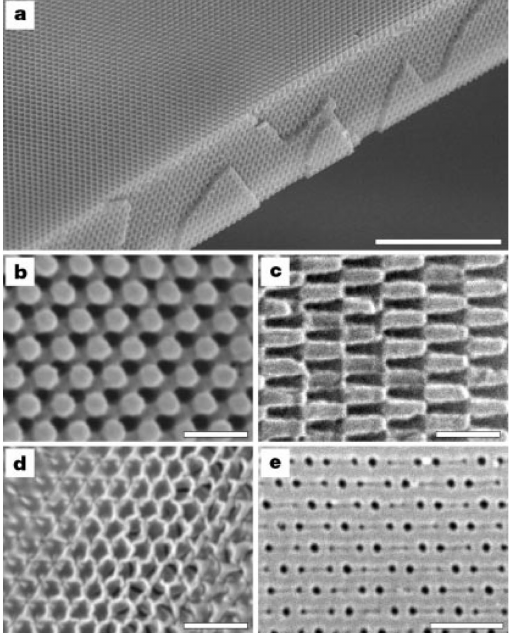
Figure 11. SEM images of SU-8/air 3D photonic crystals generated by holographic lithography. ( a ) Photonic crystal generated in 10 μ m thick SU-8 (scale bar: 10 μ m); ( b ) close-up of a (111) surface (scale bar: 1 μ m); ( c ) close-up of a (111 ) surface (scale bar: 1 μ m); ( d ) inverse replica in titania made by using the polymeric structure as a template; ( e ) (102 ) surface of a � body-centered cubic SU-8/air photonic crystal (scale bar: 1 μ m). Reprinted with permission � from [39], copyright 2000 Macmillan Publishers